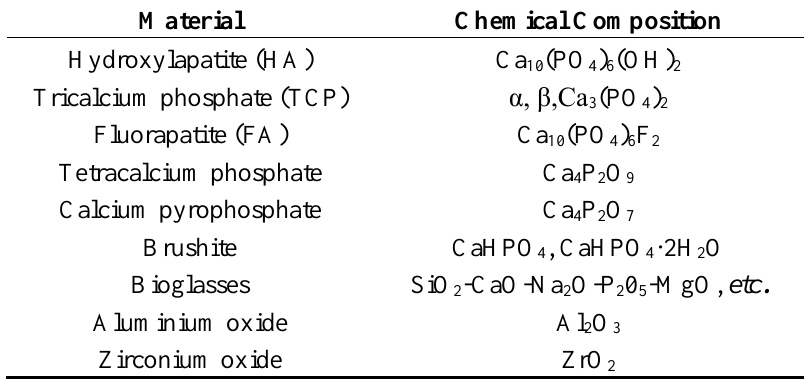
Table 3. Ceramic materials available as dental implants and